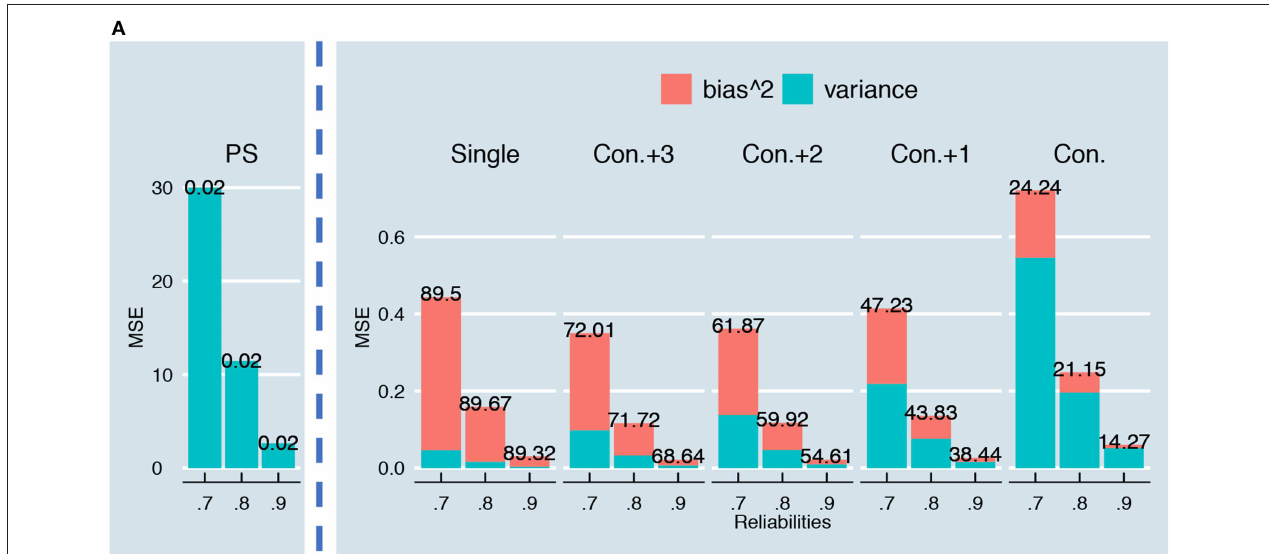
FIGURE 18 | Bias 2 , variance and MSE for a test with 24-items and K = 2 (A) , K = 4 (B) , and K = 6 (C) parallel test parts. The overall reliability of the test is varied on the x-axis. The numbers on top of the bars show the percentage of the MSE “caused” by the bias 2 , which is also reflected in the size of the stacked pink bar. Note that these plots are based on the relationship in Figure 5A; similar plots for the other relationships can be requested from the first